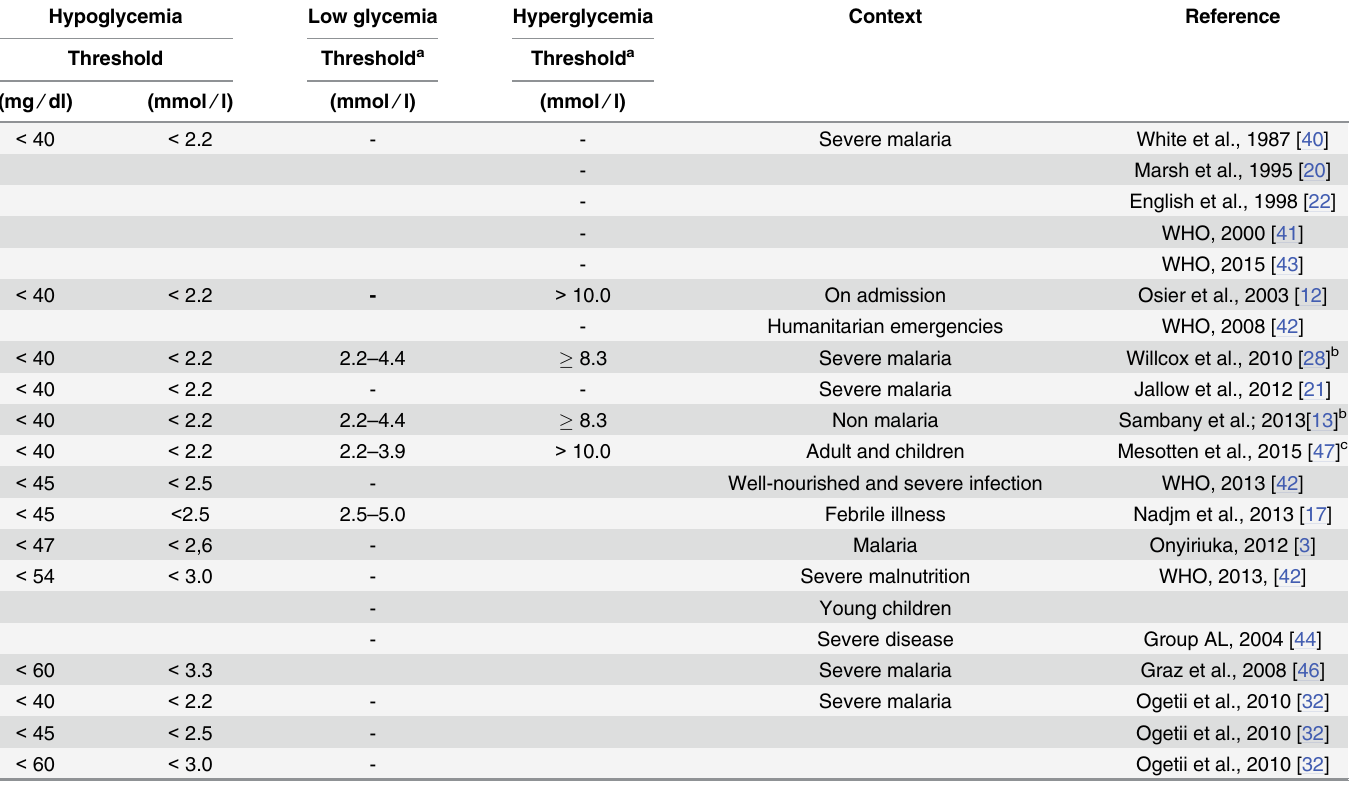
Table 1. Cut-off values recommended or used for hypoglycemia and low glycemia in non neonate children in the